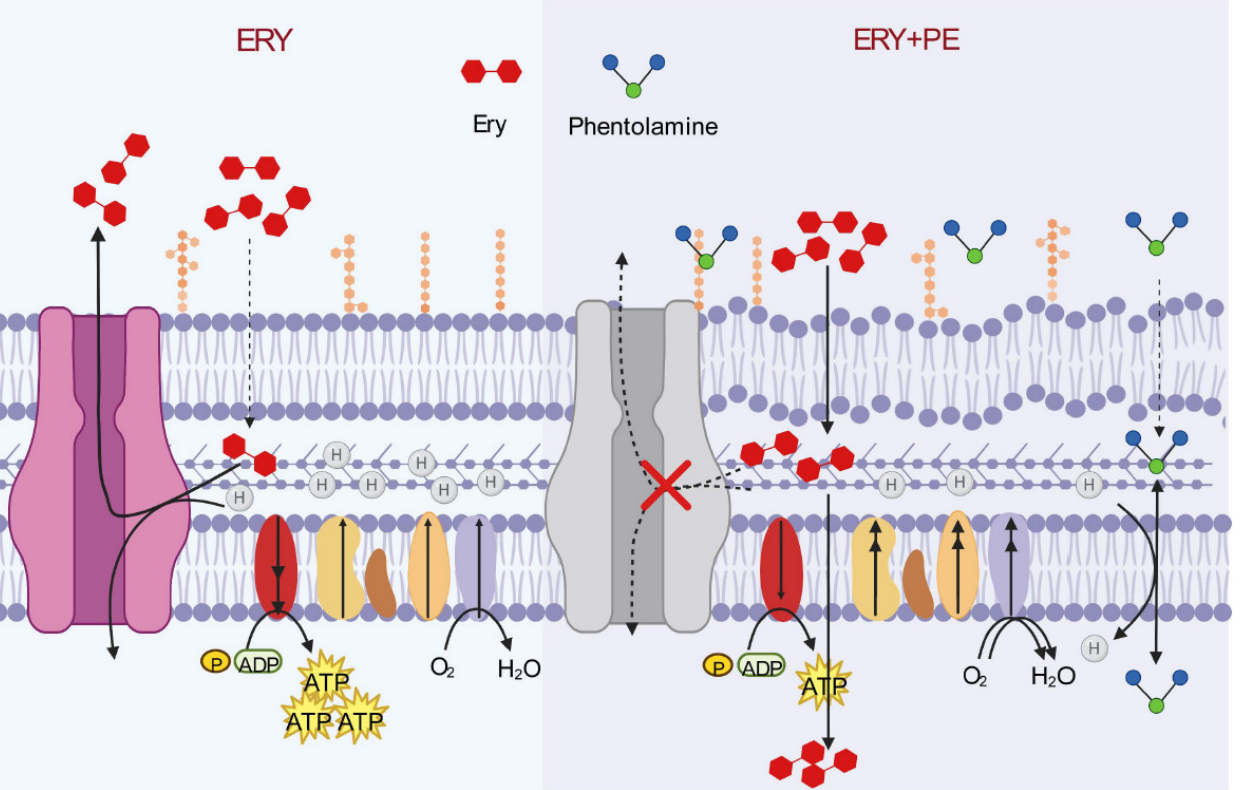
Figure 3. Proposed phentolamine mechanism of action. Phentolamine uncouples the electron transport chain, dissipates the PMF, and decreases ATP production to inhibit TolC-mediated efflux activity. Phentolamine also damages the outer membrane, and these activities enhanced ERY entry that could not be reversed by efflux pump activation. The sum of these effects are increased levels of macrolide potency against Gram-negative bacteria.